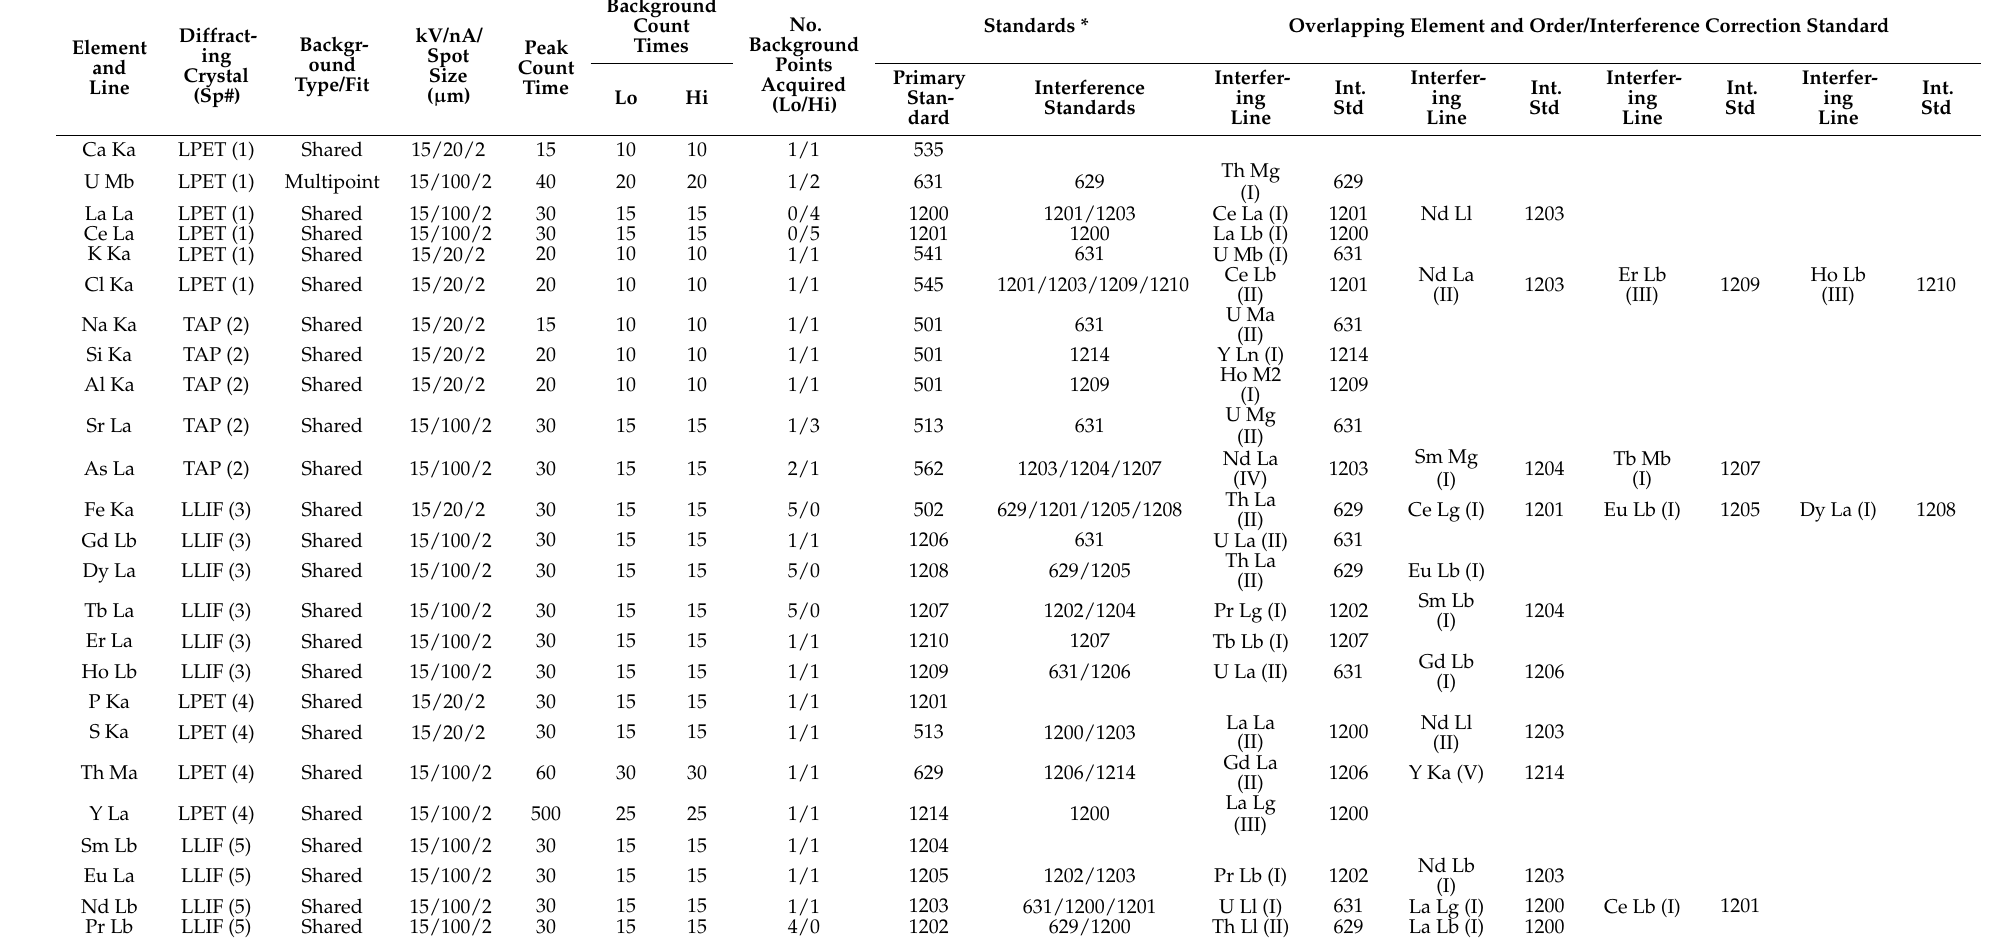
Table A1. EPMA setup for spot analysis of